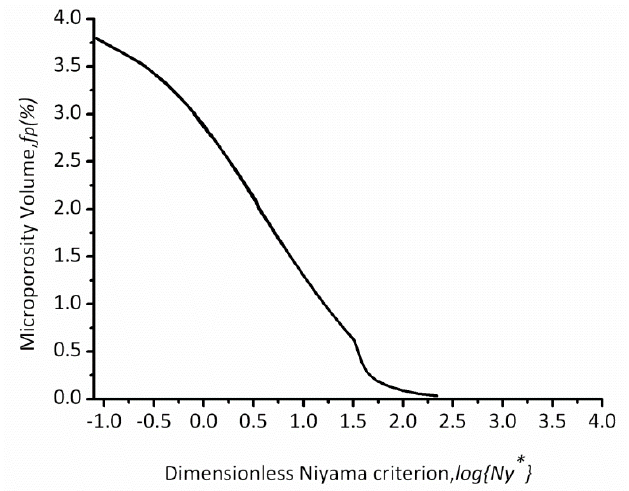
Figure 9. Predicted microporosity volume as a function of log [